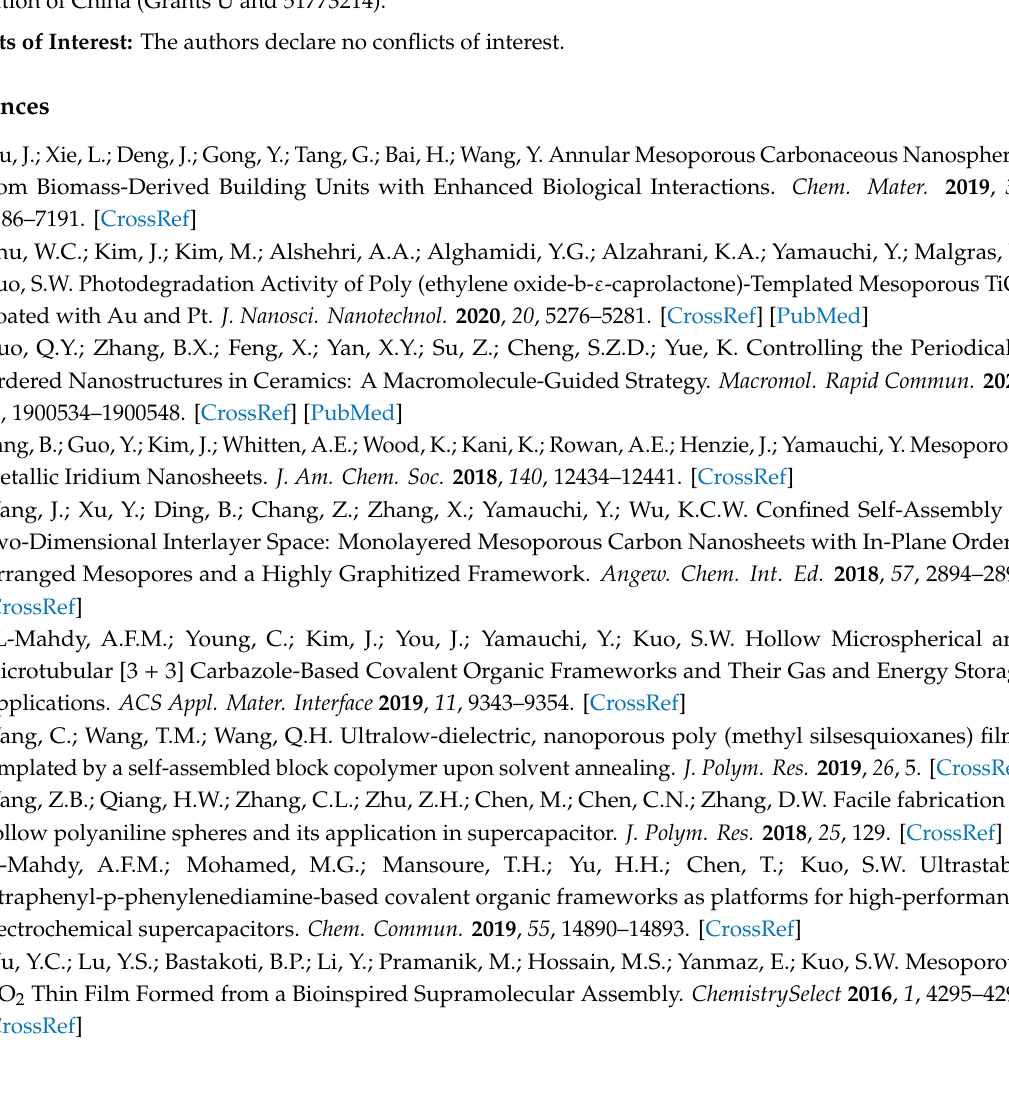
Table S1: Comparison of di ff erent carbons with surface area and capacitance